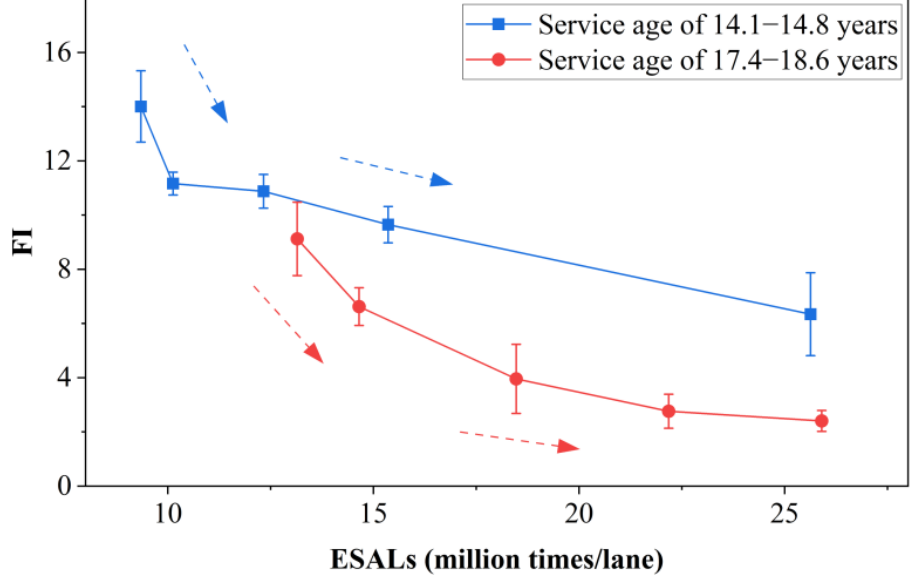
Figure 8. FI versus ESALs for samples of top layer with similar service ages. In order to investigate the relationship between FI and service age, four groups of samples corresponding to different levels of ESALs were selected. The difference in ESALs within each group was less than one million times/lane to eliminate the effect of ESALs.